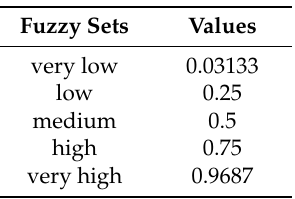
Table 6. Defuzzification table of parameter E .